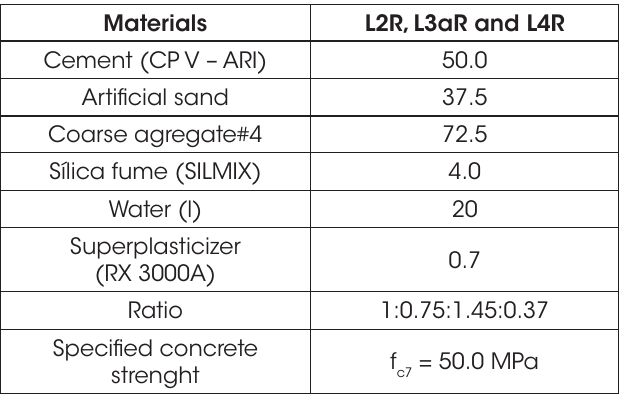
Concrete mix proportions used for strenghted concrete (kg/m³)